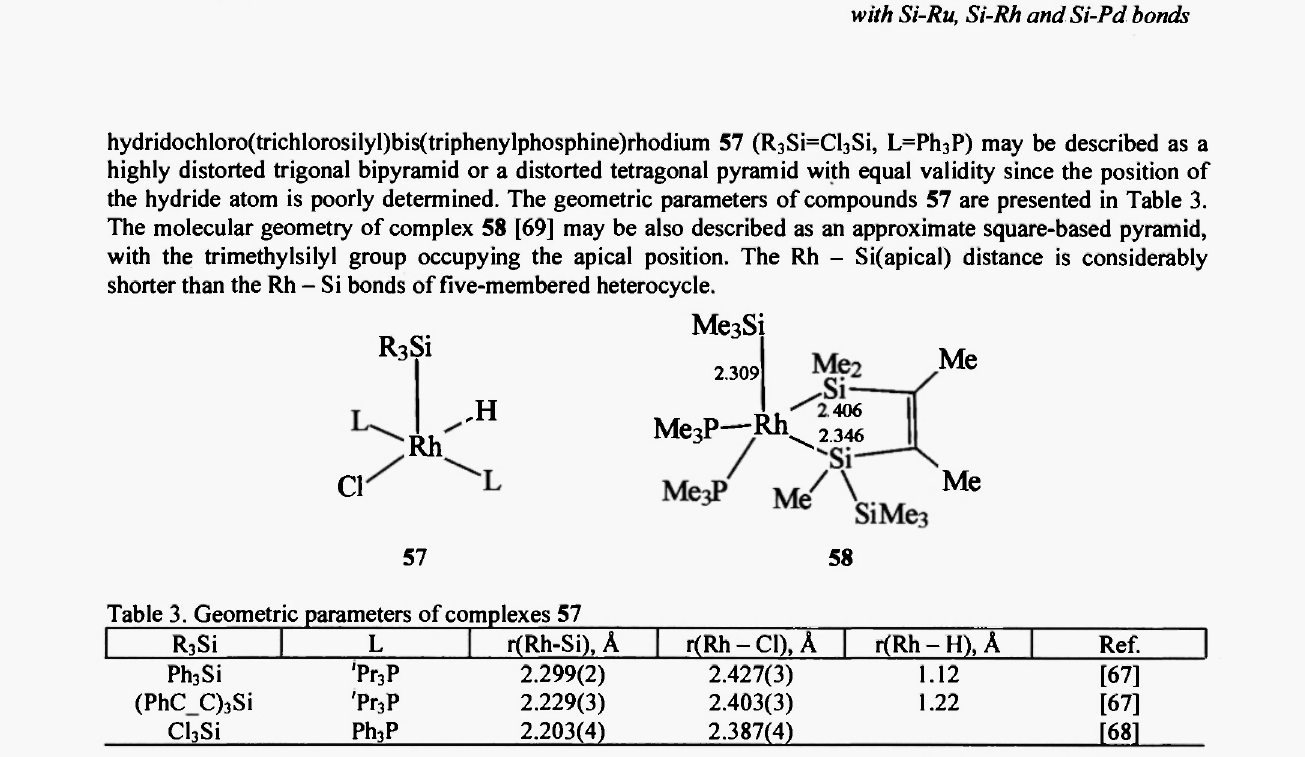
The shortest Rh - Si bond distances of 2.229 and 2.293 A (for two independent molecules) were obtained for